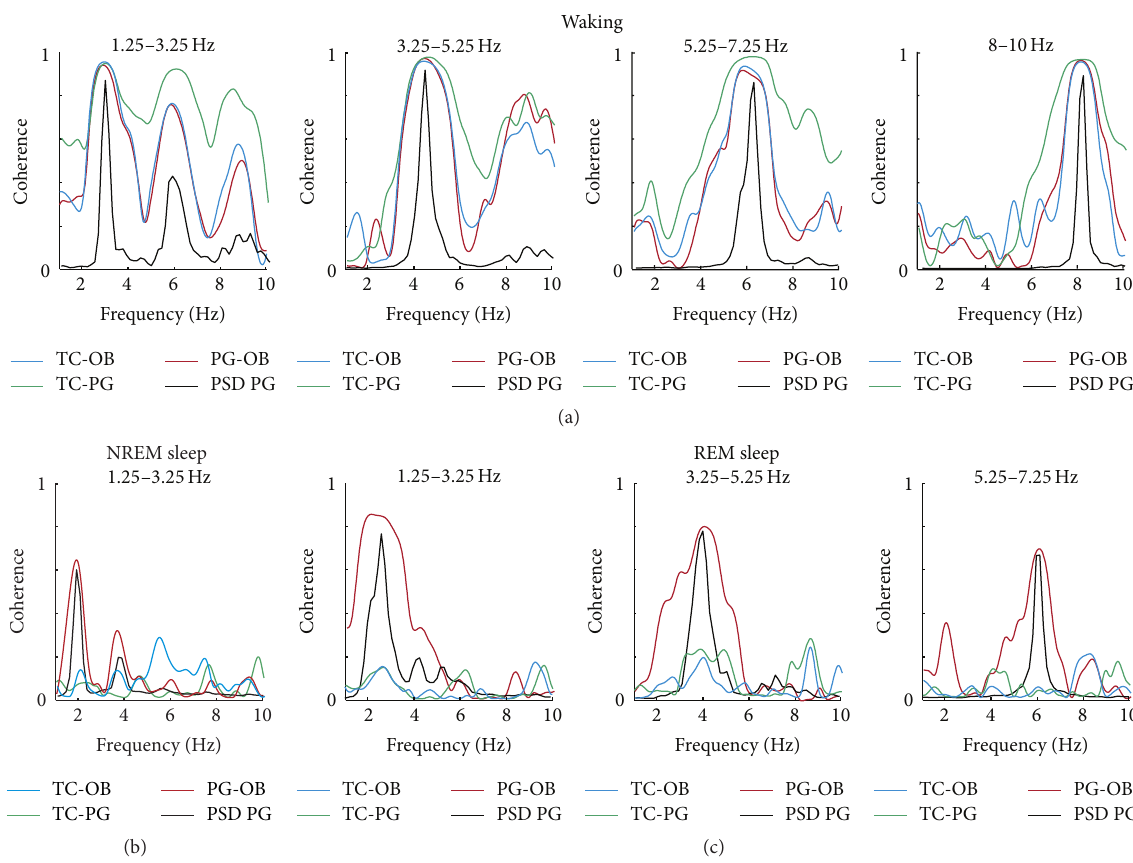
Figure 6: Representative examples of coherences between plethysmography (PG), thermocouple (TC), and olfactory bulb (OB) local field potentials (LFP) reveal clear peaks and their harmonics in waking but only between PG and OB in NREM and REM sleep (see also text for conclusions on OB LFP as source of respiration during sleep). PSD PG: power spectral density of the plethysmography